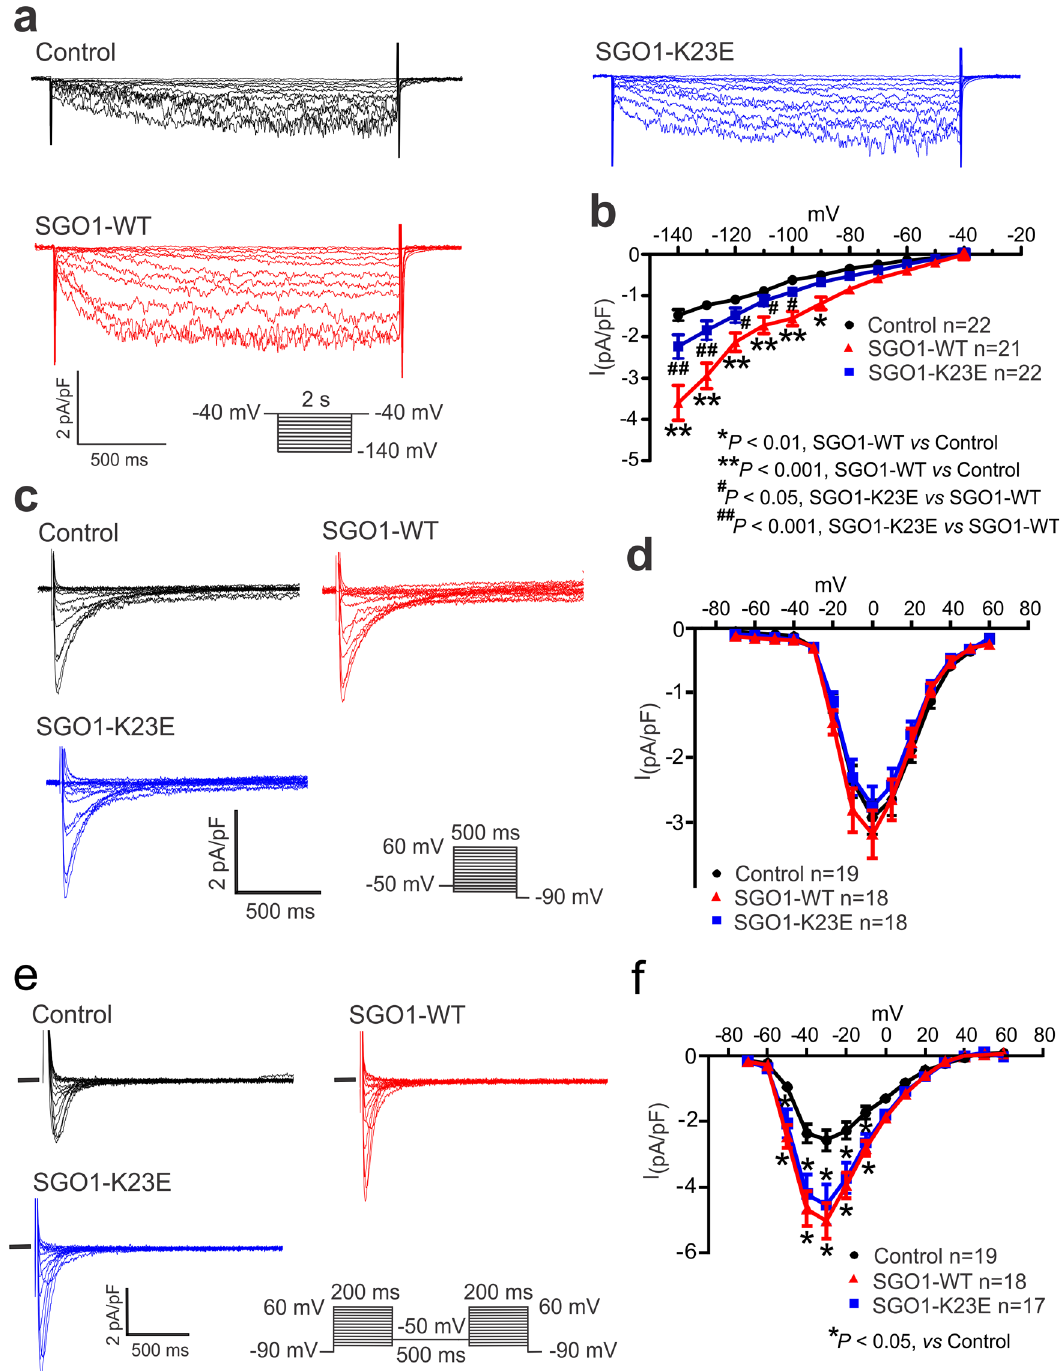
Fig. 2 Effect of SGO1-WT and SGO1-K23E on I f , I CaL and I CaT in NRVMs. a Representative I f recordings from NRVMs of control (black), SGO1-WT (red) and SGO1-K23E (Blue) preparations. b Average current density-voltage (I-V) relation of I f for control, SGO1-WT and SGO1-K23E transduced NRVMs. I f was elicited from a holding potential of − 40 mV, using 2 s voltage steps from − 140 mV to − 40 mV in 10 mV increments with an interpulse interval of 10 s. Data are mean ± SEM. Two-way AVOVA. c Representative I CaL recordings in control (black), SGO1-WT (red) and SGO1-K23E transfected (blue) NRVMs. d I-V relation of I CaL plotted from control, SGO1-WT and SGO1-K23E NRVMs. Data are expressed as mean ± SEM. e I CaT recordings in NRVMs. Two series of voltage steps of 200 ms from − 90 mV to + 60 mV were applied, separated by 500 ms intervals at − 50 mV to inactive I CaT (protocol delivered at 0.1 Hz). I CaT was obtained by subtracting the currents with a holding potential of − 50 mV (only I CaL ) from those with a holding potential of − 90 mV (I CaL + I CaT ). f I-V relation for I CaT . Data are mean ± SEM. Two-way AVOVA. n ’ s in fi gure are number of separate cells